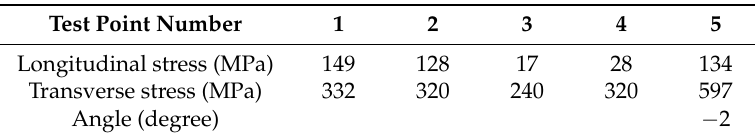
Table 9. Residual stress of weld longitudinal joint.